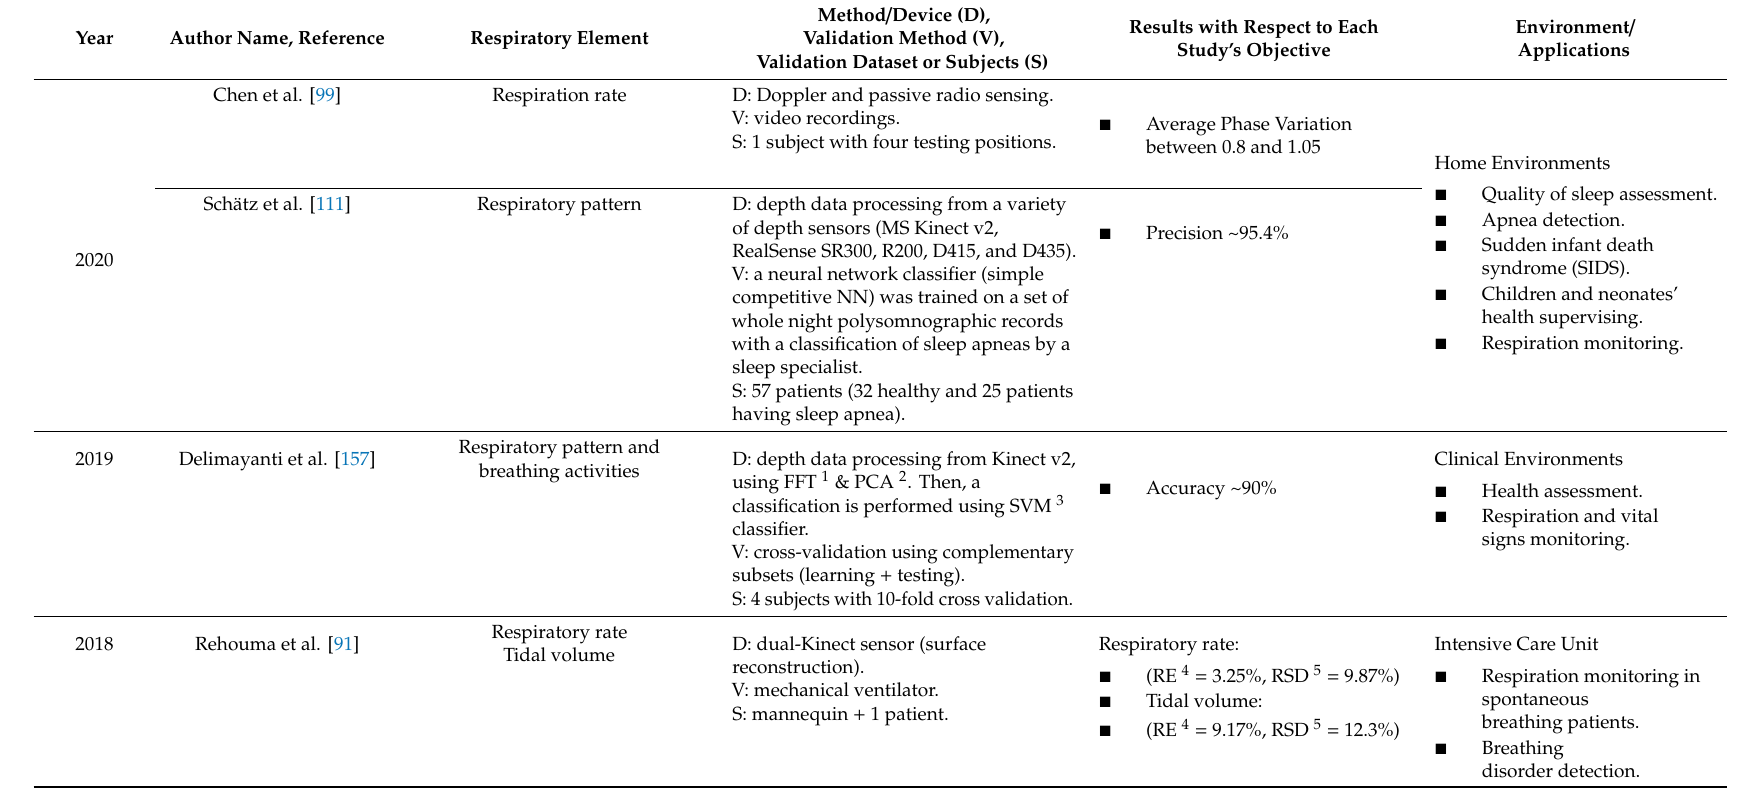
Table 4. Summary of recent respiratory systems and their